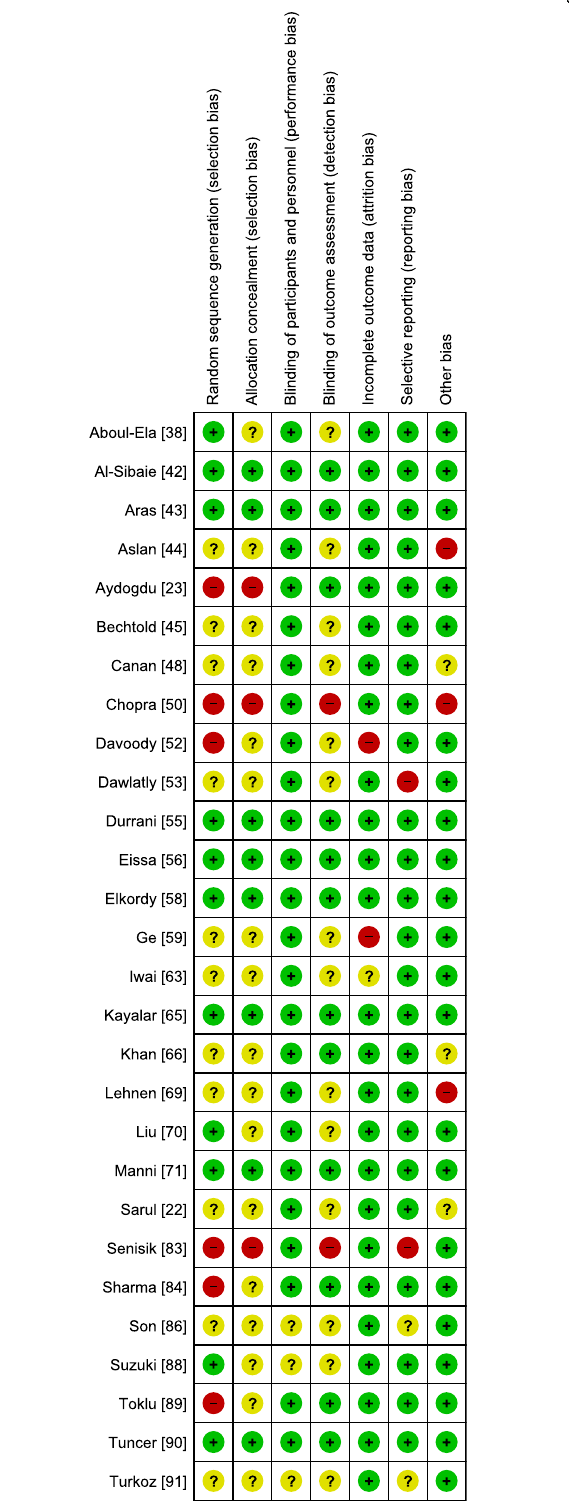
Fig. 2 Risk of bias summary, high risk of bias (red), low risk of bias (green), and unclear risk of bias